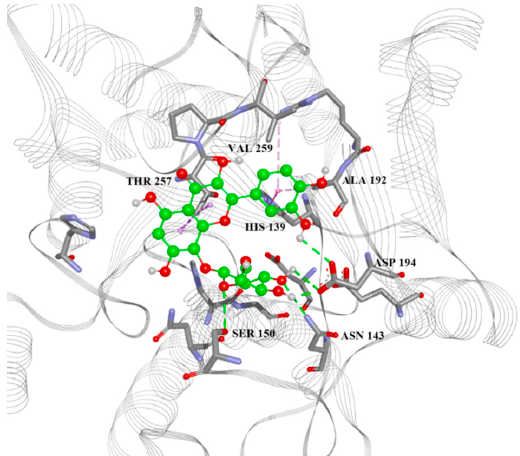
Figure 6. The binding site of Leishmania arginase in the homology model, with the most important residues for interaction listed.